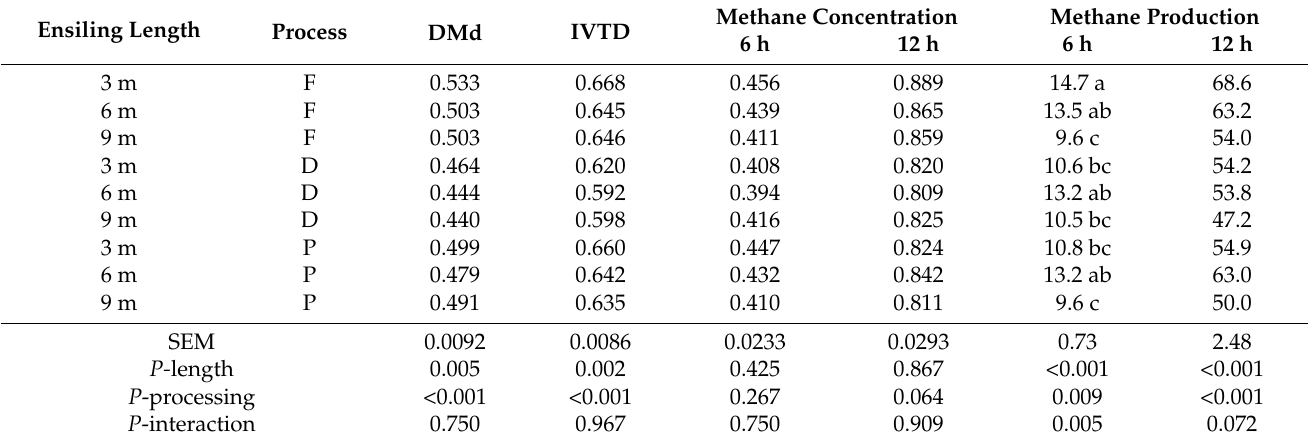
Table 4. Dry matter disappearance after 48 h (DMd), in vitro true digestibility (IVTD), and methane concentration ( µ mol/mL gas) and production ( µ mol/g OM) at 6 and 12 h of incubation of silages opened after 3, 6, and 9 months, before (F) and after processing (dehydrated, D, or dehydrated and pelleted,